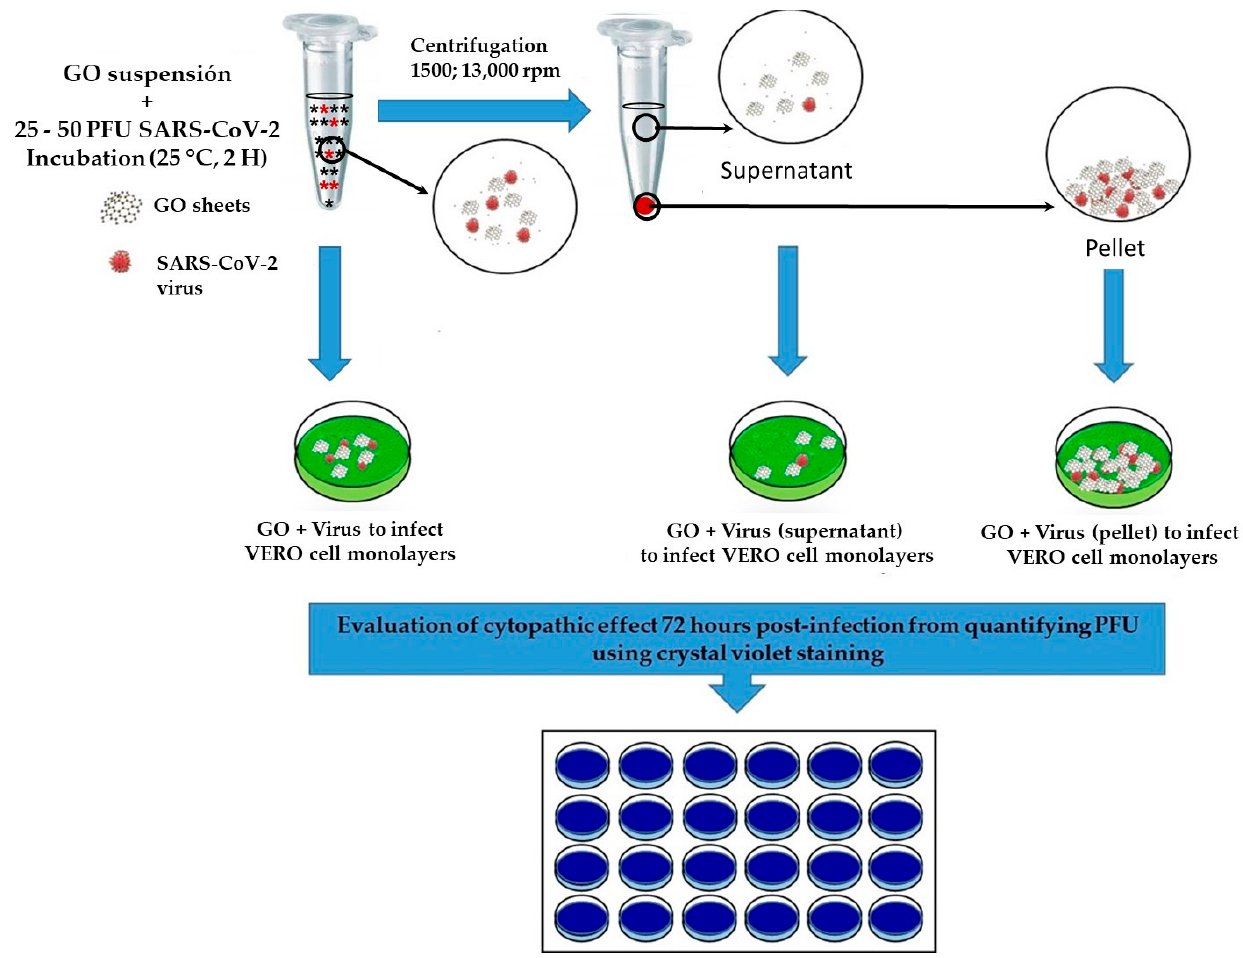
Figure 1. Schematic evaluation of GO antiviral activity by reducing viral plaque formation in VERO cells. Table 1. Description of the GO samples studied.